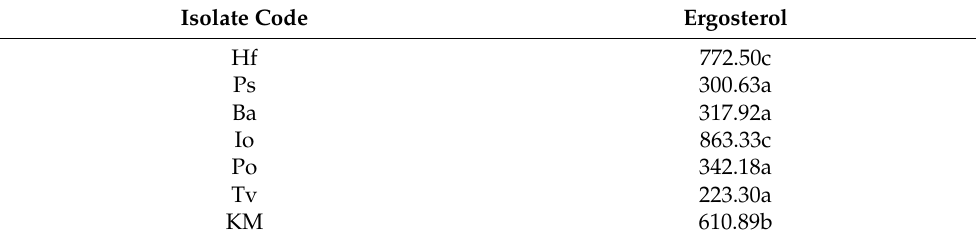
Figure 3. Comparison of carotenoids (1-lutein, 2-zeaxanthin, 3- β -carotene, 4-astaxanthin) UPLC chromatograms: Io (green line), Po (black line), Ba (blue line). Table 5. The carotenoids concentration ( mg/kg ) in 7 fungal isolates. Table 6. The ergosterol (ERG) concentration (mg/kg) in 7 fungal